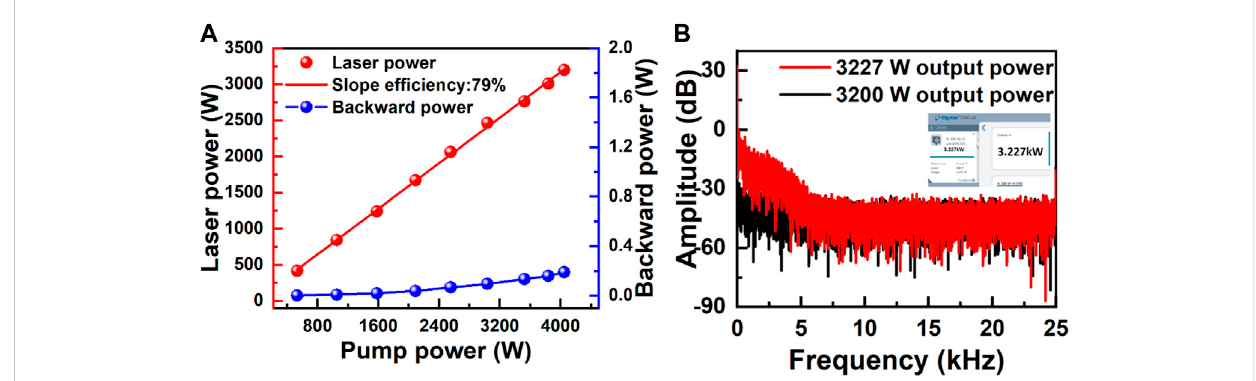
FIGURE 6 ThelaserperformanceofthePMYDF-3whentheMIissuppressed. (A) LaserpowerandbackwardpowerofaMOPAsystemversusthepumppower. (B) Frequency-domain characteristics before and after MI. Inset: power display screenshot at the laser power of 3.227 kW.